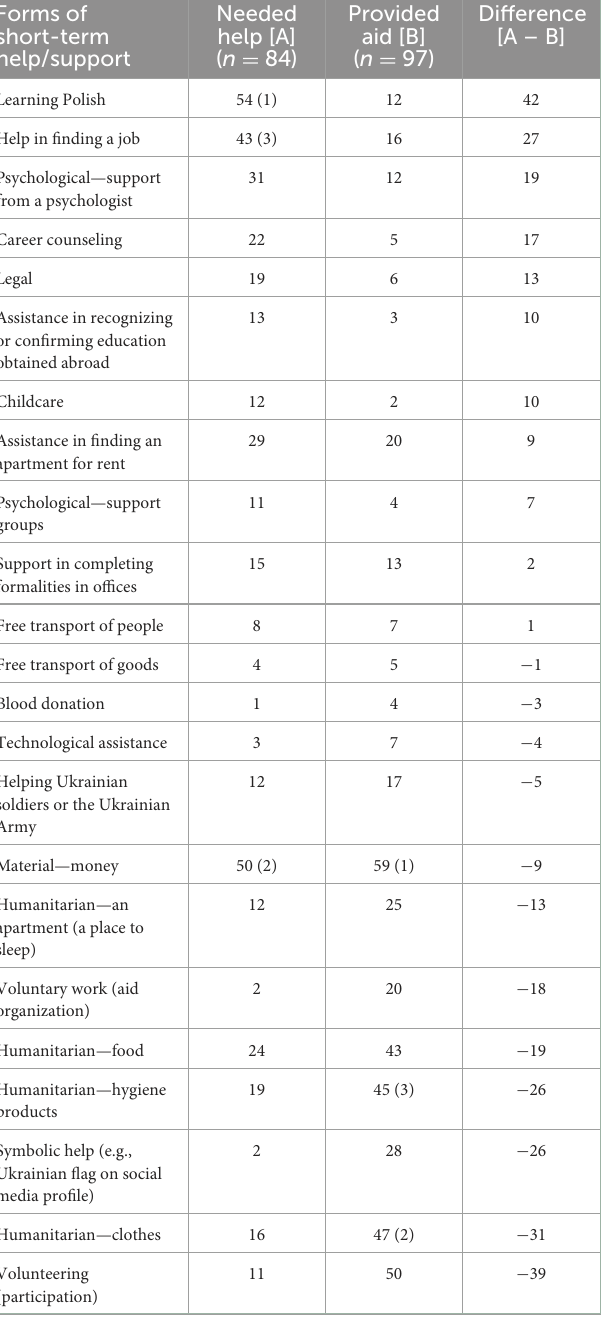
TABLE 7 Forms of long-term aid from the perspective of the needs of refugees, the aid provided by supporters, and the difference between